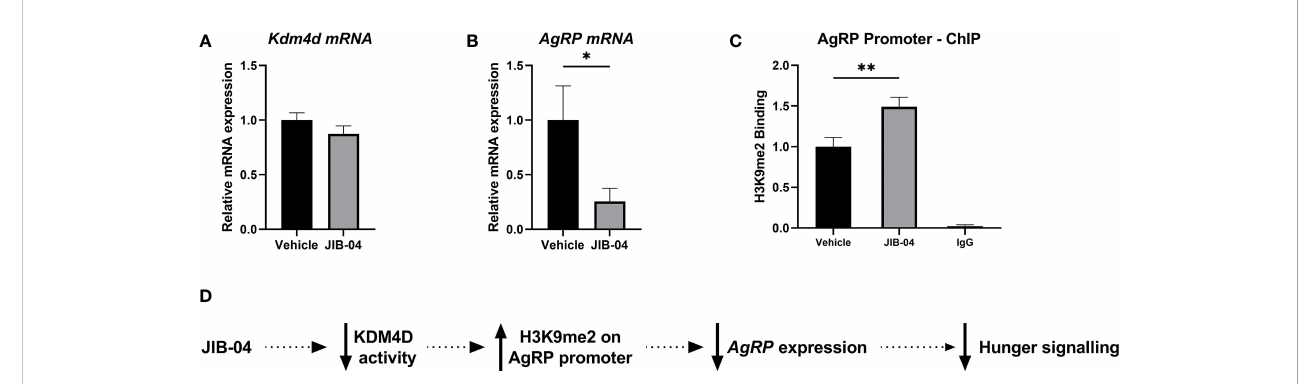
FIGURE 5 Histone methylation at H3K9 promotes satiation signaling and decreased feeding (A, B) Speci fi c gene expression of the ARC was measured using RT- qPCR with primers designed for (A) Kdm4d and (B) AgRP . (C) ChIP-qPCR was performed with anti-H3K9me2 and primers aligned to the promoter of AgRP to assess histone enrichment. (D) Schematic presentation of proposed mechanism of de/methylation of histone tail, regulating AgRP expression. In JIB-04 treated rats, the activity of KDM4D is inhibited, cementing the di-methylation status of H3K9 on the AgRP promoter. This in turn represses AgRP expression, inhibiting the hunger signaling and decreasing feeding. Data are presented as mean ± SEM, and signi fi cant effects between groups are indicated as * 0.01 < P < 0.05, **0.001 < P <